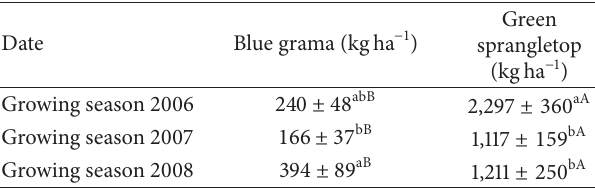
Table 5: Forage dry matter production (mean ± SE) of blue grama ( Bouteloua gracilis ) and green sprangletop ( Leptochloa dubia ) under different dates at a seeded abandoned field in Chihuahua, Mexico.